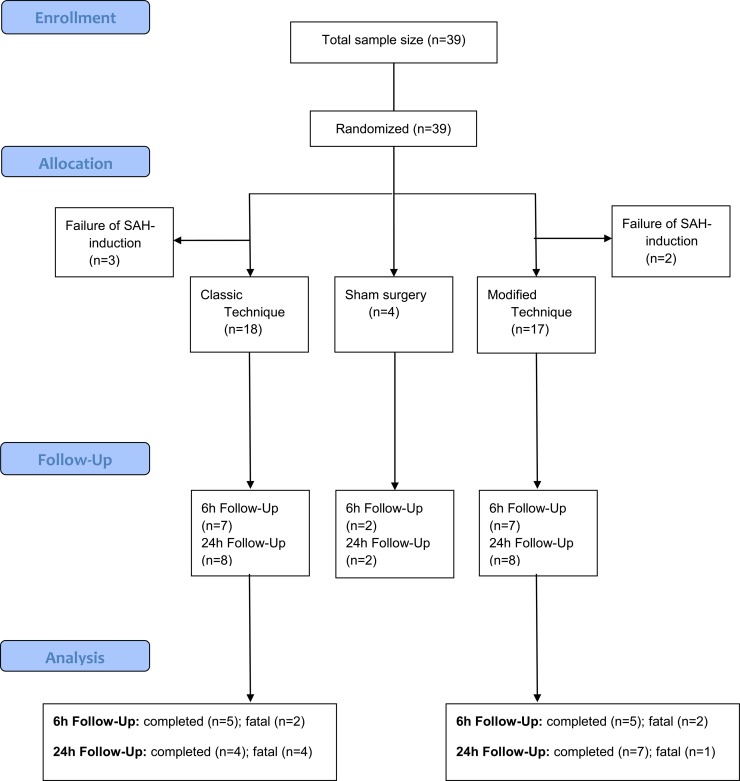
Diagram of animals enrolled.Diagram of animals enrolled: total sample size n = 39, invalid rCBF-data in n = 3 (6 h modified technique n = 1; 24 h modified technique n = 2).